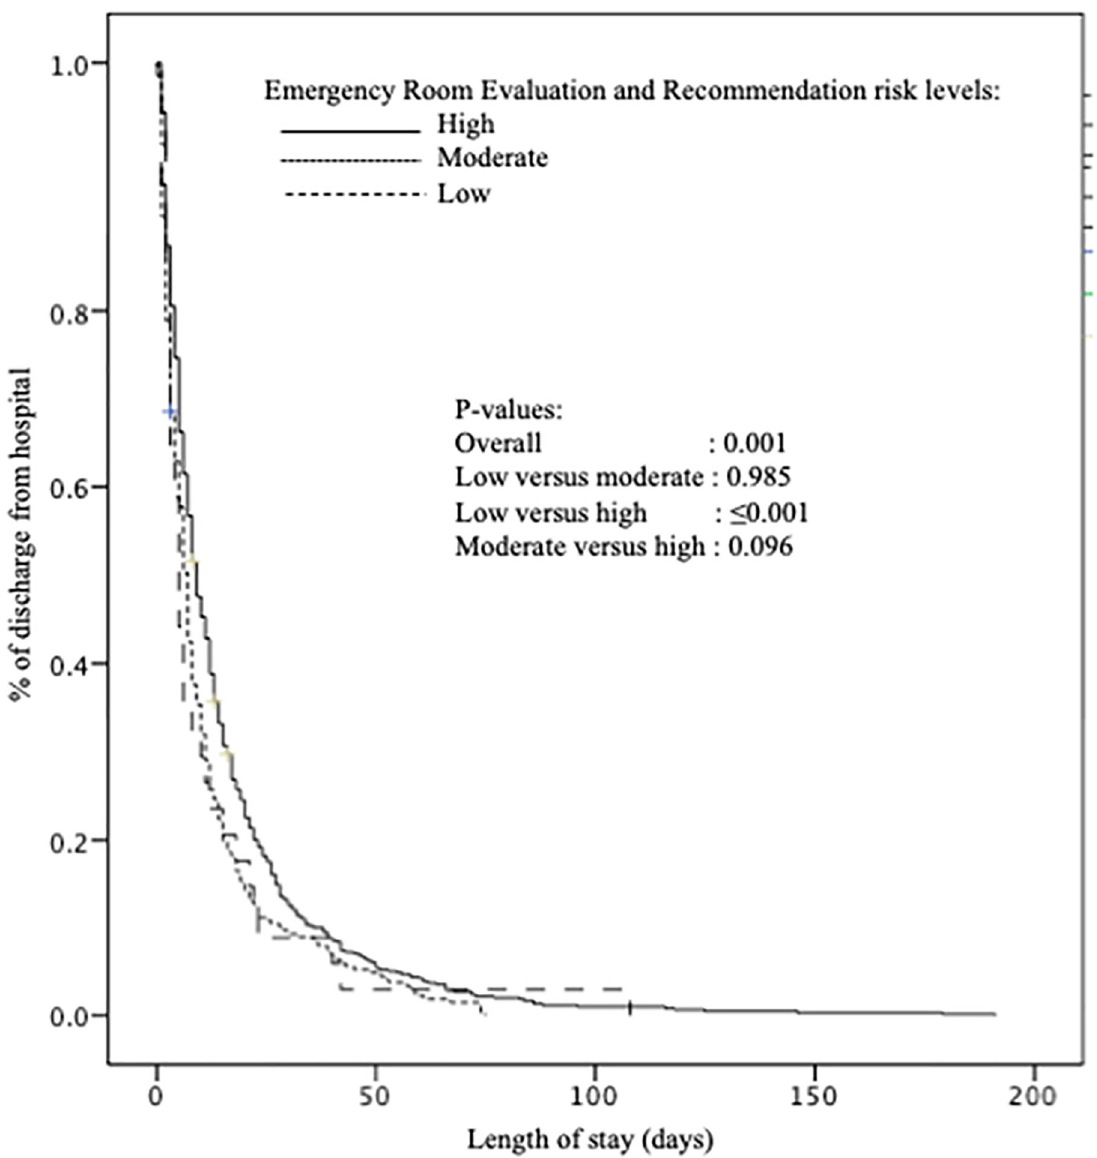
Fig 3. Kaplan-Meier estimates of the probability of discharge from hospital to a non-hospital location based on the ER 2 risk-levels (i.e.; low, medium, high) (n = 1,800).